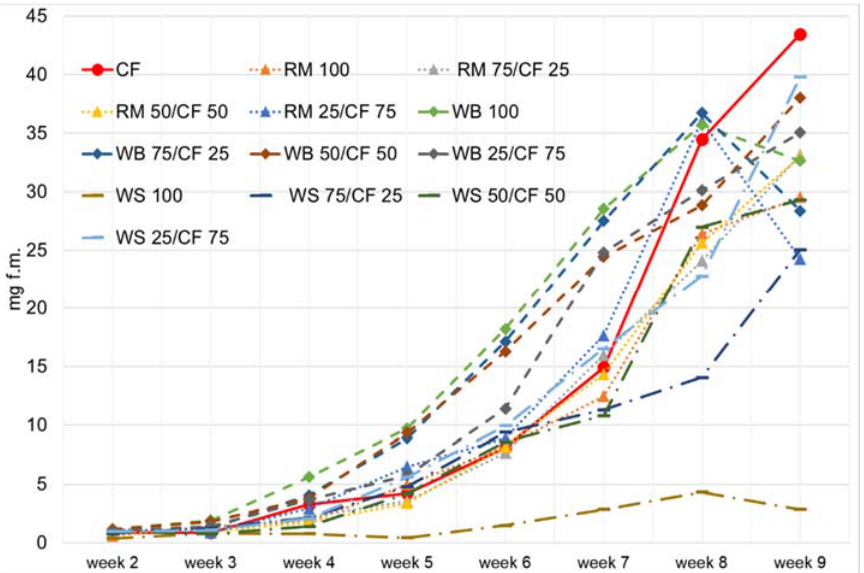
Figure 2. Individual larval weight gain depending on the type of diet and week of rearing; CF (chicken feed), RM (rapeseed meal), WB (wheat bran) and WS (willowleaf sunflower).